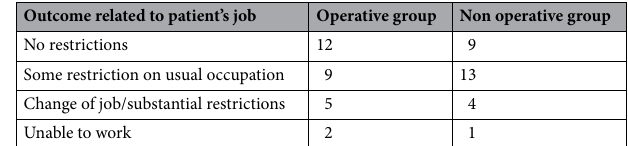
Table 5. Outcome related to the job of patients at 1 year follow up.